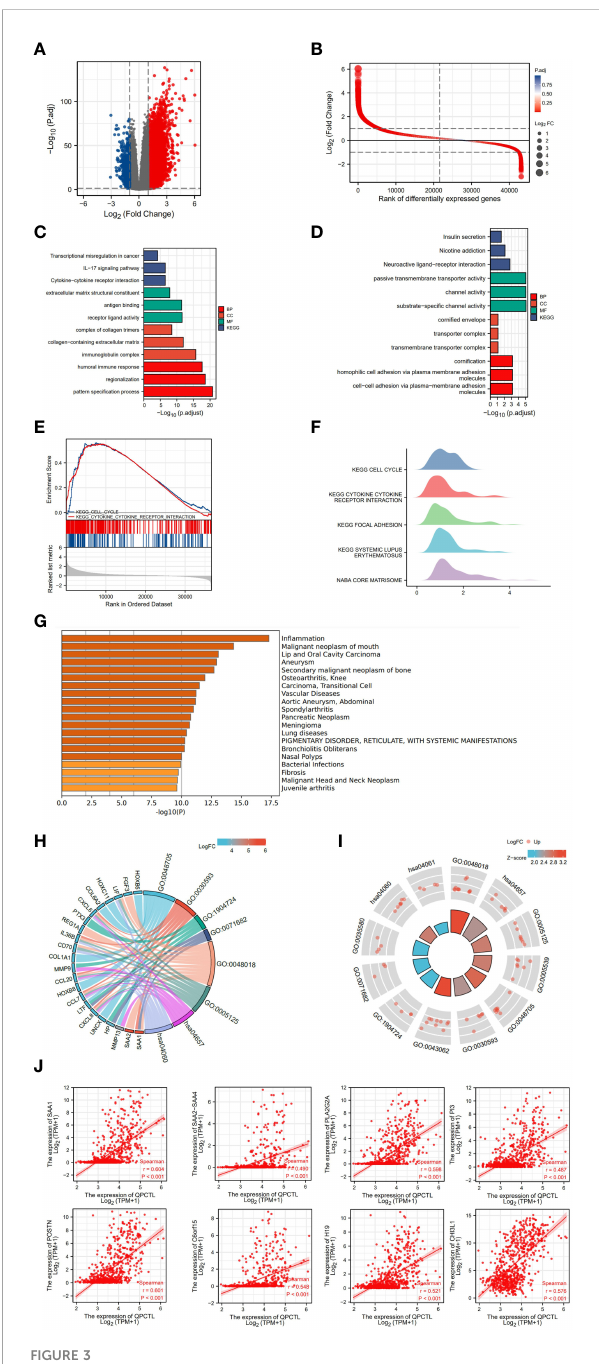
FIGURE 3 Differentiated gene analysis of QPCTL-high and -low groups in LGG patients. (A) The volcano plot shows the DEGs in QPCTL-high and -low groups. (B) The rank of differentially expressed genes. (C) The GO and KEGG analysis of high-expressed genes in QPCTL-high groups. (D) The GO and KEGG analysis of low-expressed genes in QPCTL-low groups. (E) The GSEA or the DEGs. (F) The GSEA in the ridge plot of DEGs. (G) The GO analysis of highly expressed genes via the website https://metascape.org/. (H, I) The combinational analysis of GO and KEGG of high-expressed genes in the QPCTL- high group. (J) The Pearson correlations between QPCTL and the top eight highly expressed genes in